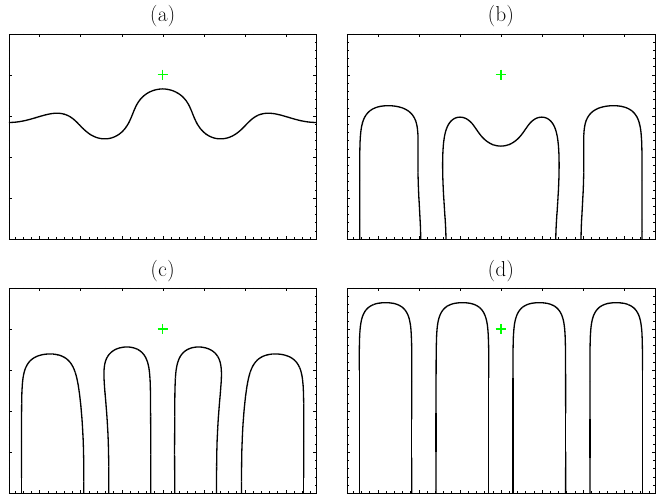
Figure 8. Moving contact line at T = 10 ( a ), T = 20 ( b ), T = 30 ( c ), and T = 75 ( d ). L X = 30, θ s = 60 ◦ (75 ◦ inside contamination spot, denoted by a green cross).